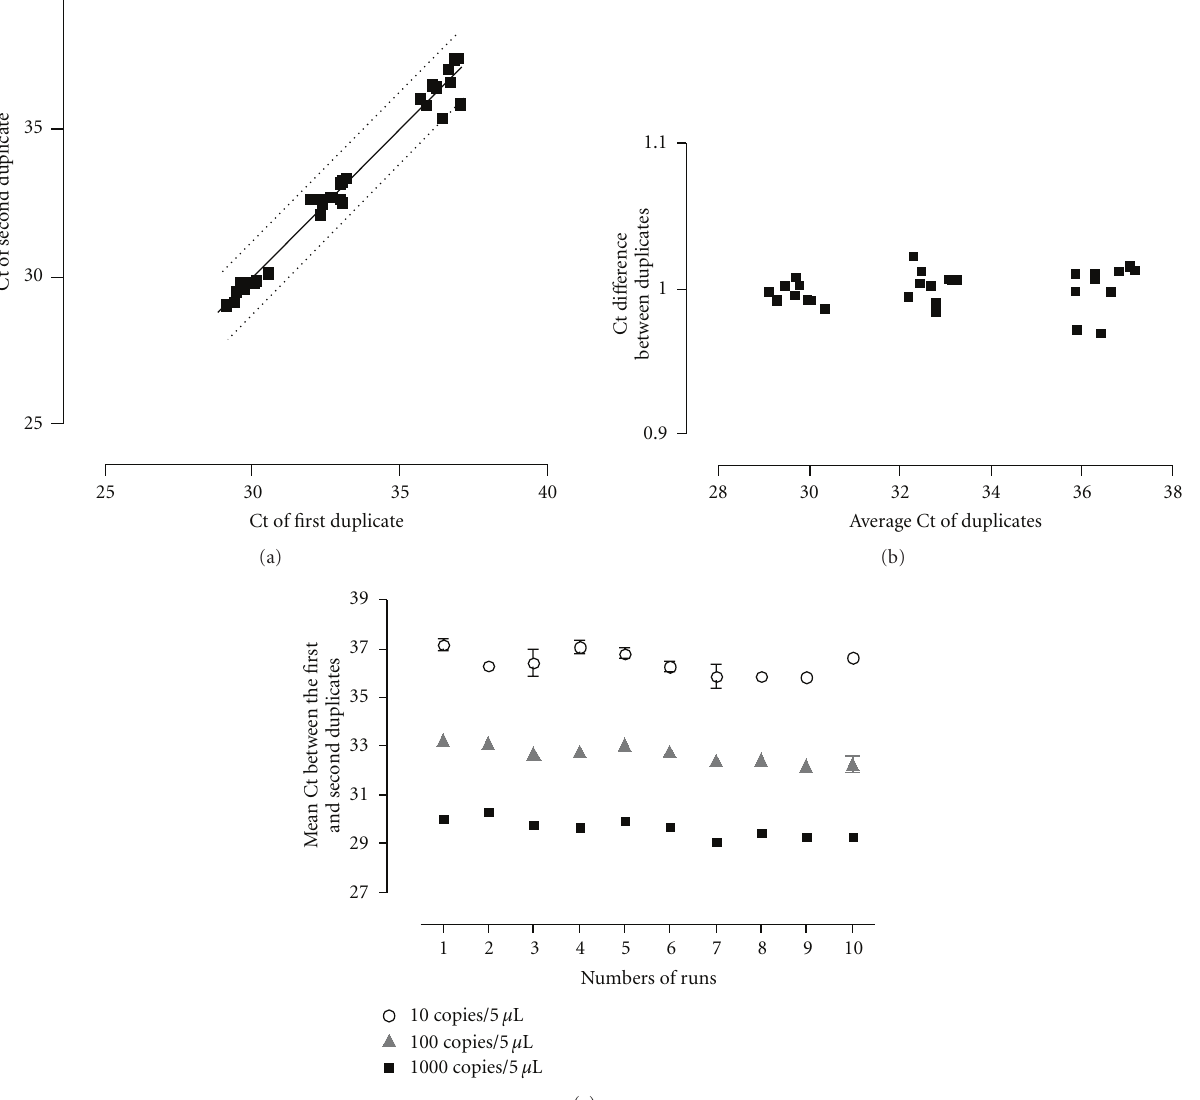
Figure 1: Intra and interrun reproducibility of the real-time PCR assessed on duplicate of plasmid positive controls performed at 10-fold dilutions from 1000 to 10 plasmid copies/5 μ L during 10 successive runs. (a) Plots of the cycle threshold (Ct) of first and second duplicates, showing intrarun variability of the real-time PCR between duplicates of positive plasmid controls; 95% confidence interval is shown by the dashed lines. (b) Bland-Altman graph showing the ratio of Ct of both duplicates according to the mean of the Ct of duplicates. (c) Plots of the mean of duplicate of plasmid positive controls according to each successive run, showing the low interrun variability of the real-time PCR. Standard deviations show the intrarun reproducibility of the